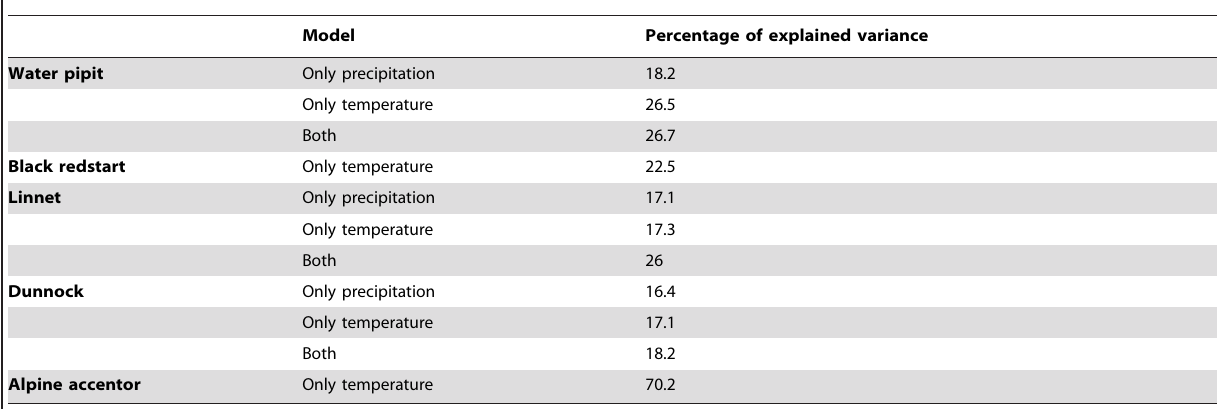
Table 4. The importance of each climate variable.